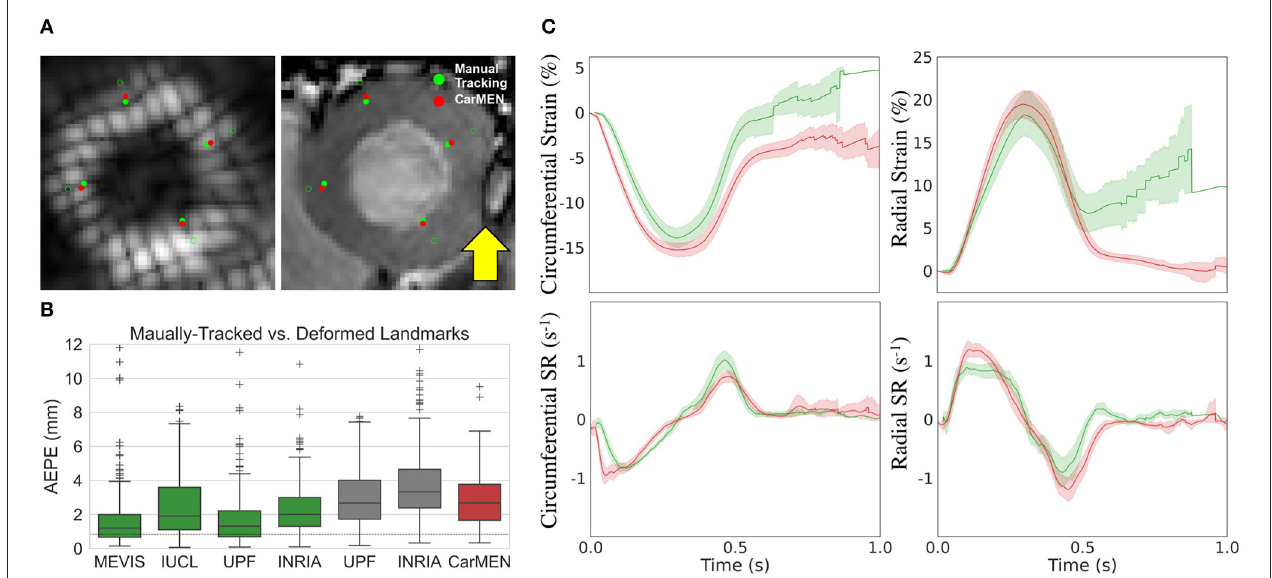
FIGURE 5 | Validation of motion and strain using the CMAC dataset. (A) Landmarks at end-diastole (unfilled green) are manually-tracked (green) and deformed with CarMEN to end systole (red). Yellow arrow indicates a banding artifact. (B) Average end-point-error (AEPE) at end-systole between manual and CarMEN-deformed landmarks was assessed and compared to other methods. (C) MEVIS- (green) and DeepStrain-based (red) strain (top) and strain rate (SR, bottom) measures are compared.